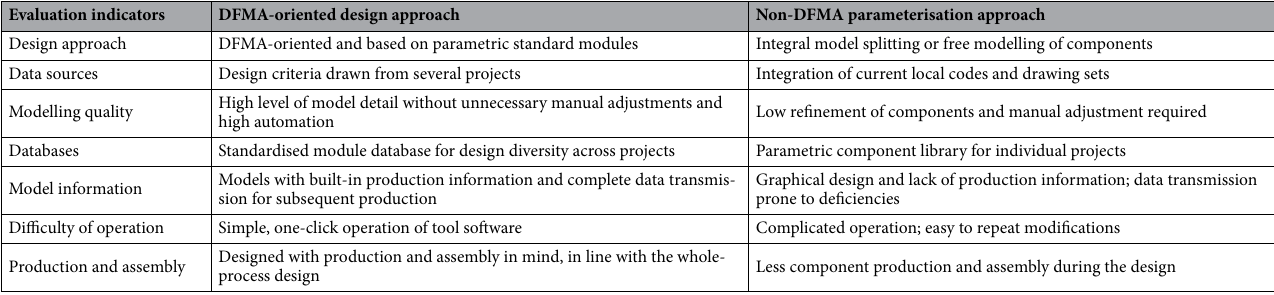
Table 4. Evaluation of design